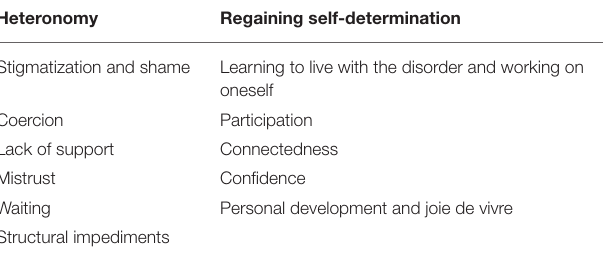
TABLE 1 | Overview themes and subthemes. Heteronomy Regaining